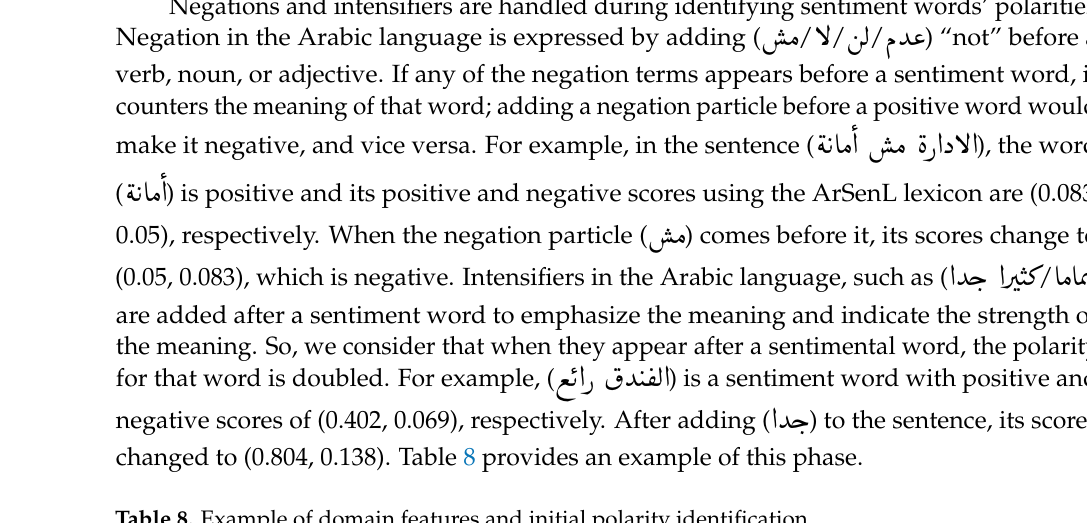
Table 8. Example of domain features and initial polarity